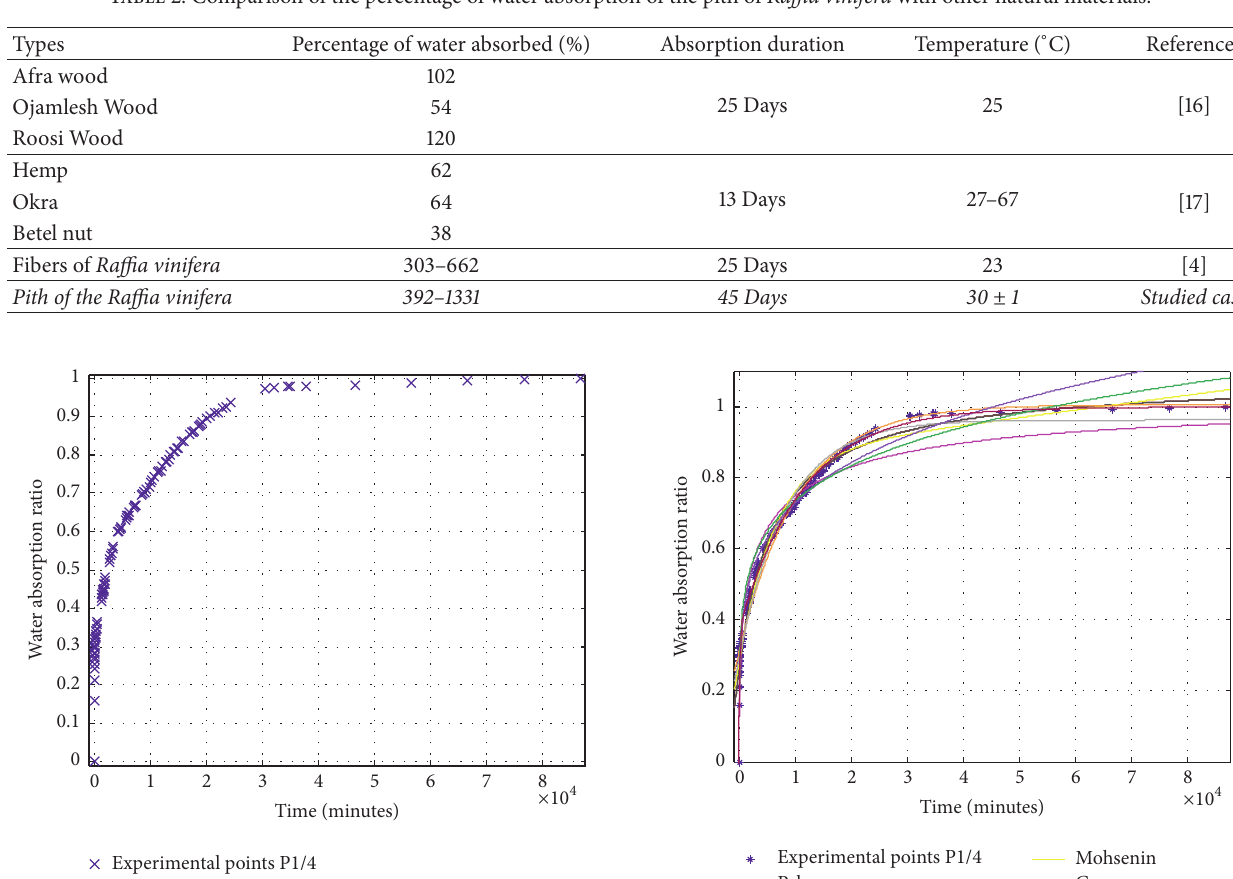
Figure 4: Average of the water absorption kinetics of the pith of Raffia vinifera from the center and at the base of the stem (1/4).